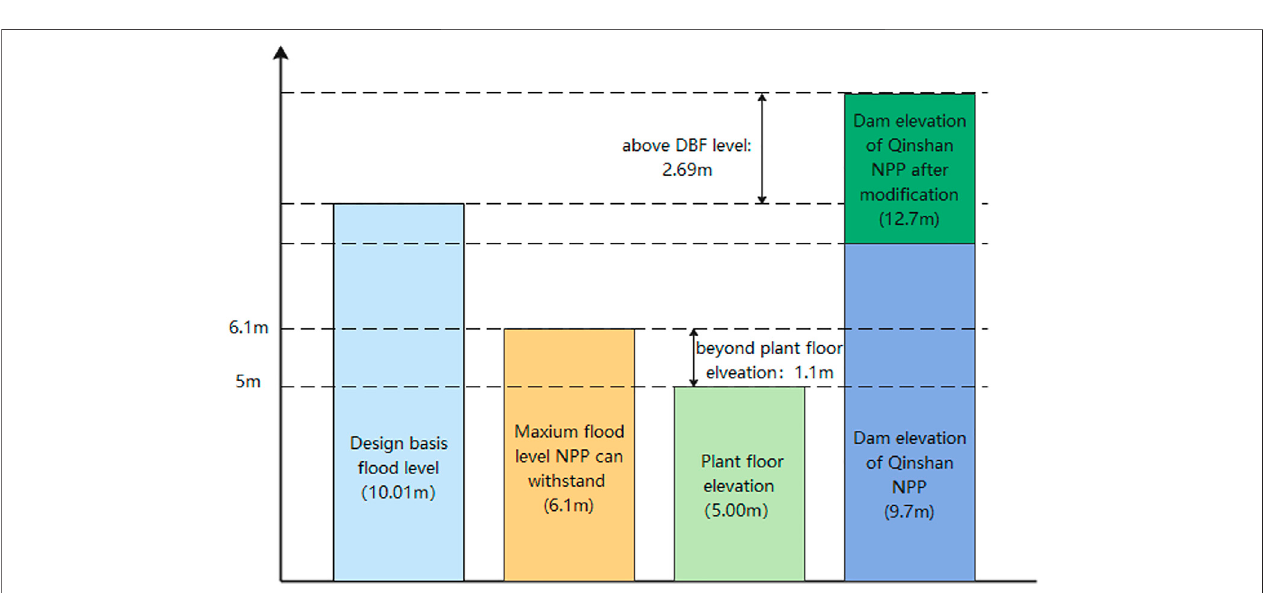
FIGURE 3 | Flood safety margin assessment and improvement of Qinshan